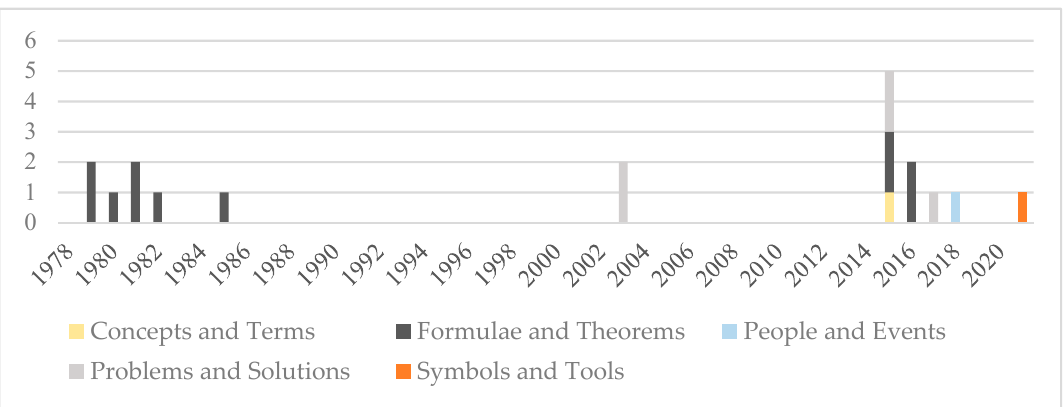
Figure 5. Histogram of the changes in the number of items in different sub-categories of the category of Historical Topics .